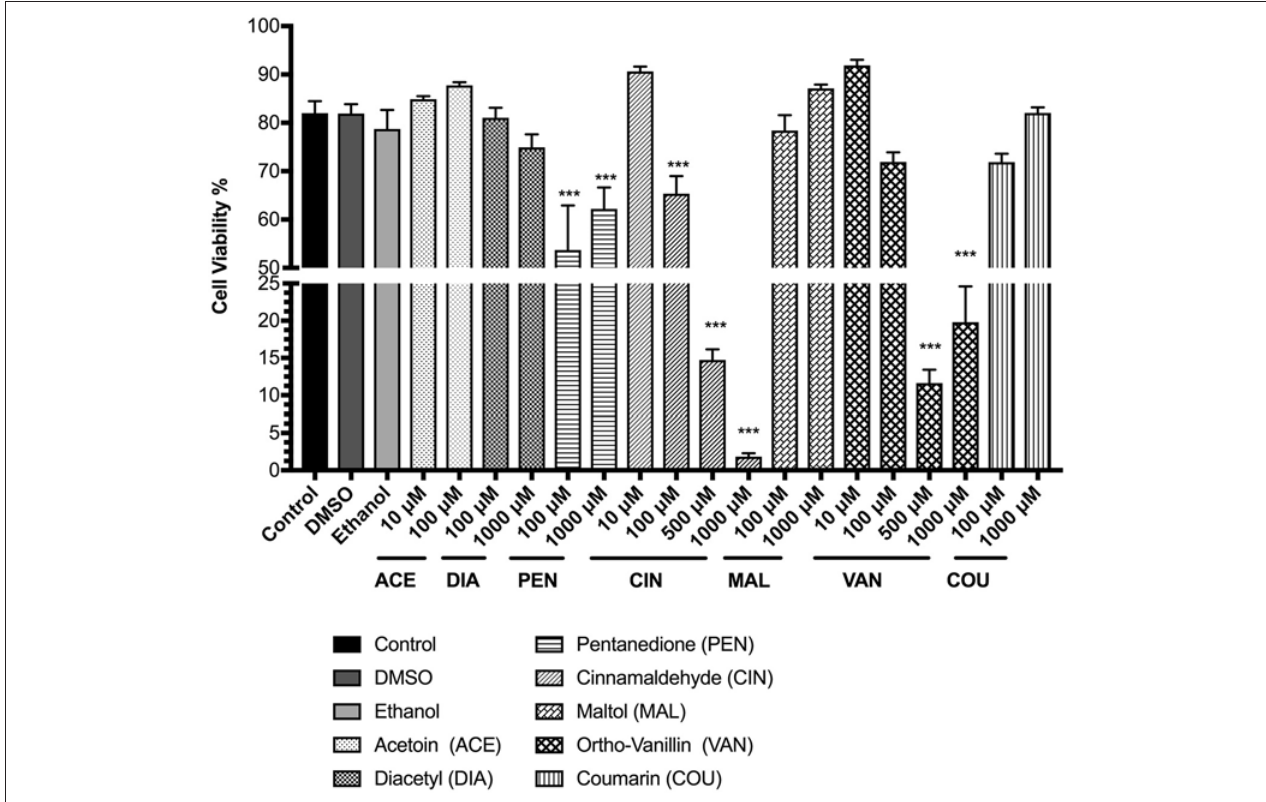
FIGURE 1 | Percent viability of U937 cells 24h post-exposure to e-cigarette flavoring chemicals, i.e., acetoin, diacetyl, pentanedione, cinnamaldehyde, maltol, o-vanillin, and coumarin at concentrations between 10 μ M and 1,000 μ M. U937 monocytes were treated with e-cigarette flavoring chemicals at varying concentrations and incubated at 37 ◦ C with 5% CO 2 for 24h. Cells were rinsed with PBS and stained with AO/PI dye. The viability of the cells was assessed using the Cellometer 2000. Data are expressed as mean ± SEM ( n = minimum 3 per group). Statistical significance was determined by one-way ANOVA (Tukey’s multiple comparison test). *** p < 0.001 vs.